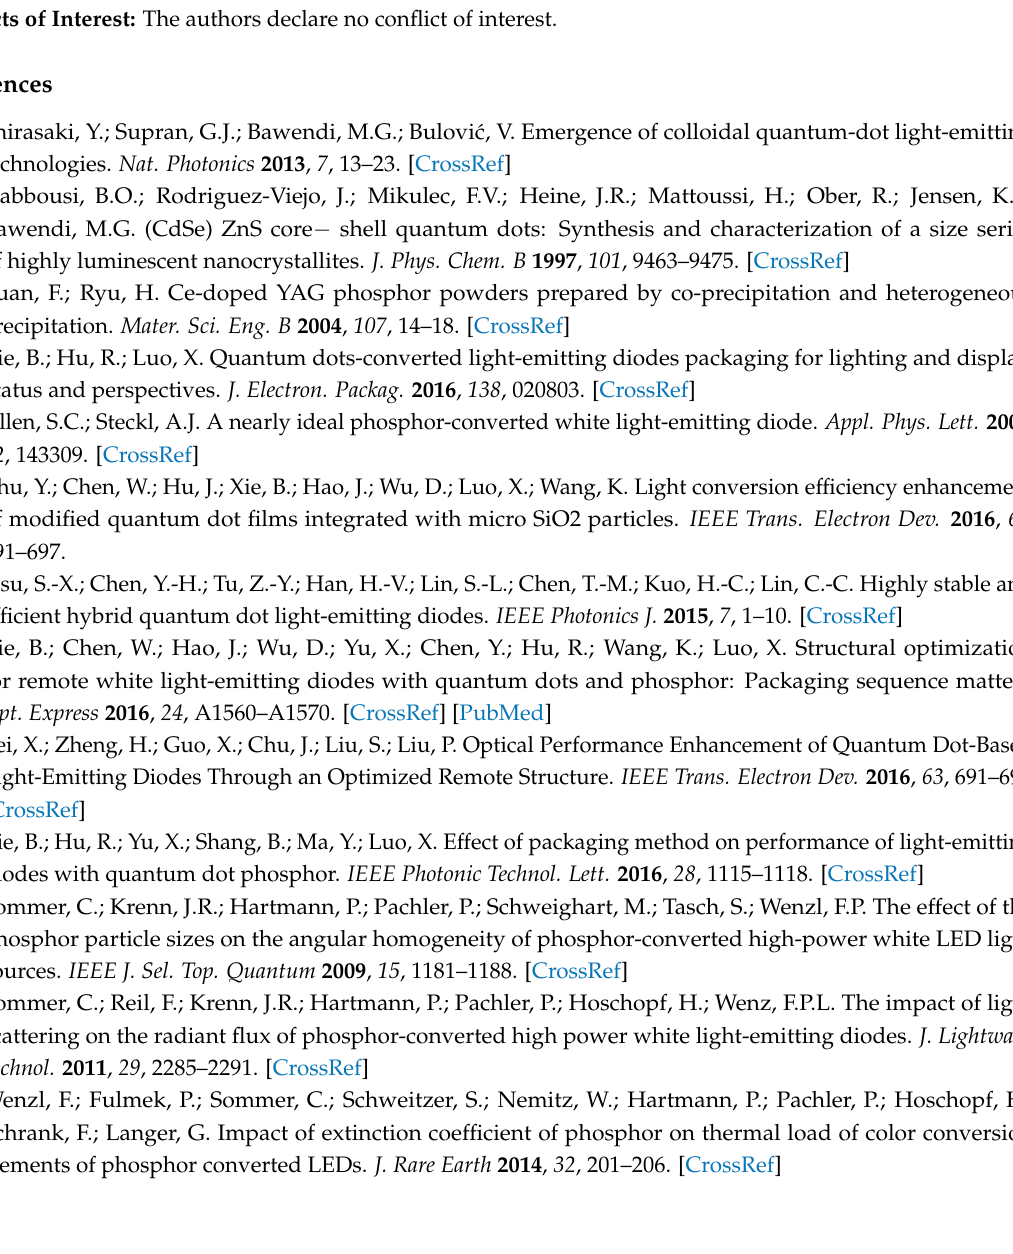
Figure S1: Scattering and absorption cross-sections of YAG phosphors. Figure S2: Scattering and absorption coefficients of quantum-dot-converted elements (QDCE) with 4.2 nm (5 molecule layers) CdSe/ZnS QDs. (MLs: molecular layers.). Figure S3: Scattering and absorption coefficients of quantum-dot-converted elements (QDCE) with 5.2 nm CdSe/ZnS quantum dots (QD). (MLs: molecular layers.). Figure S4: (a) Scattering and (b) absorption coefficients of phosphor-converted elements